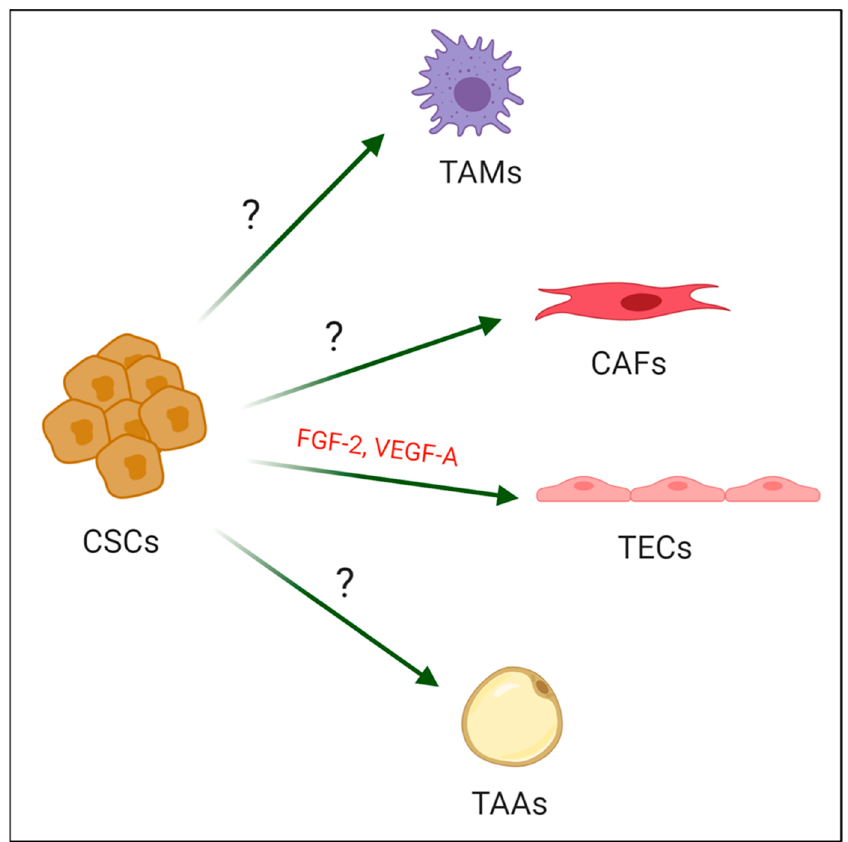
Figure 1. A schematic illustration showing cancer stem cells’ (CSCs) differentiation into tumor stromal cells, Tumor-associated macrophages (TAMs), cancer-associated fibroblasts (CAFs), Tumor endothelial cells (TECs) and Tumor-associated adipocytes (TAAs). Created with BioRender.